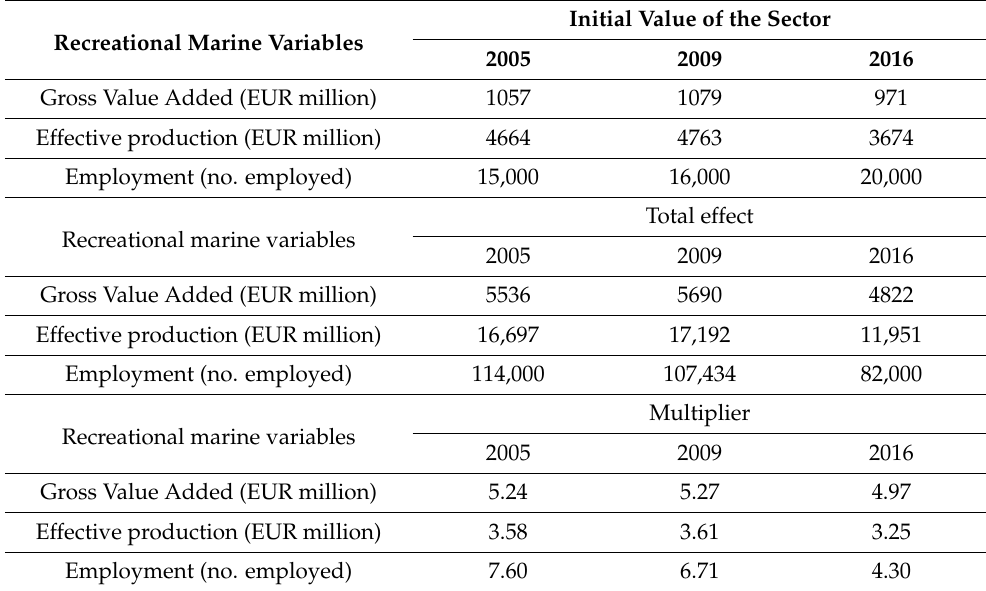
Table 3. Gross Value Added, Effective production, and Employment generated by